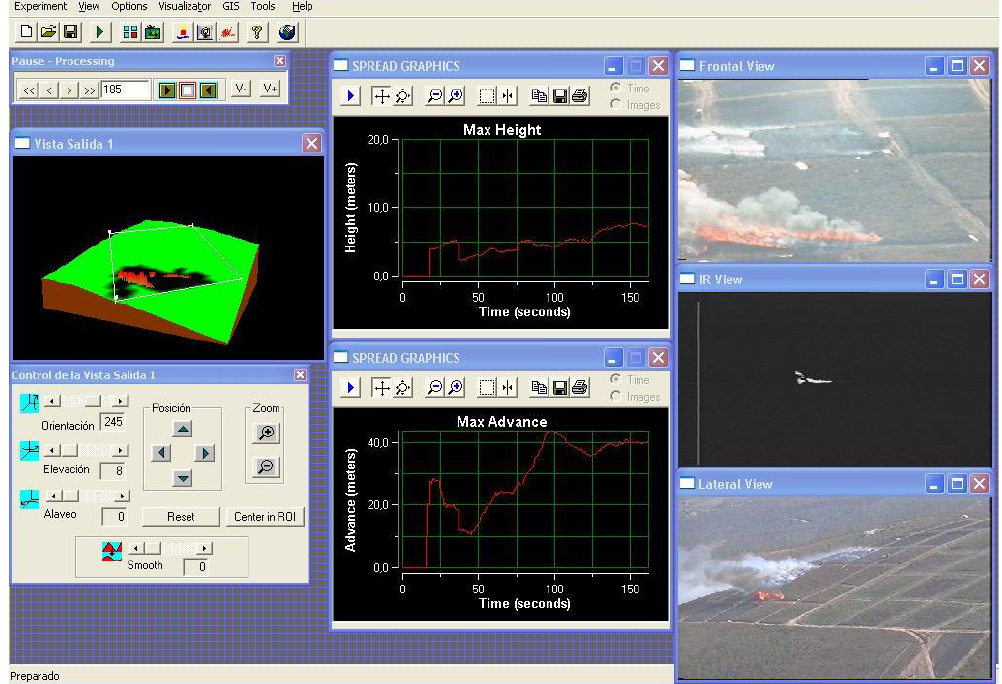
Figure 13. Screenshot of the fire measurement system during an